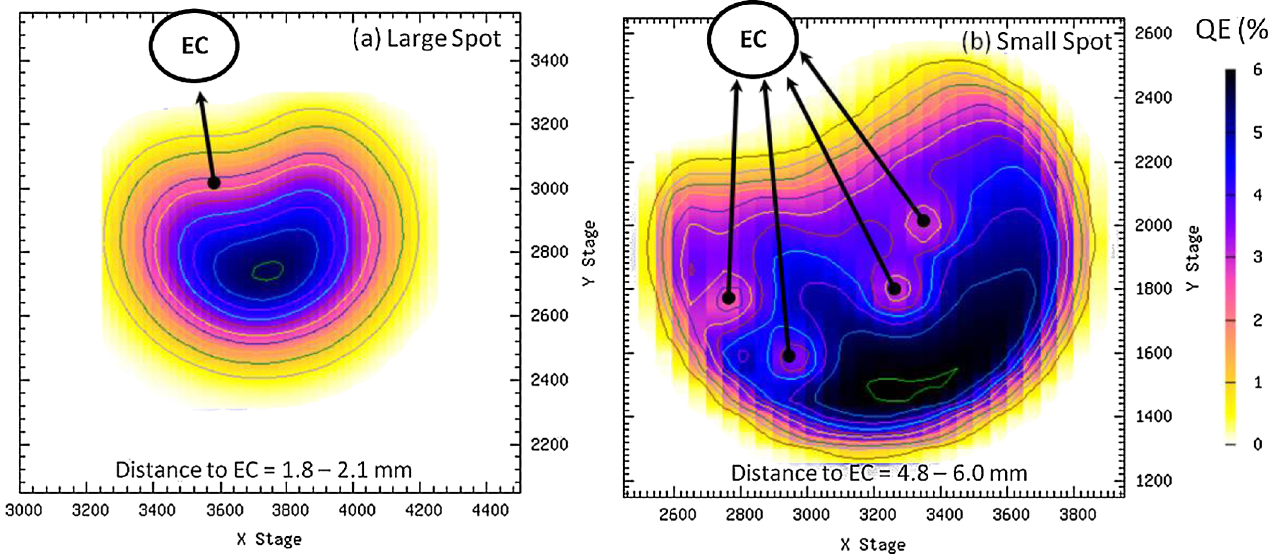
FIG. 10. False color plots of photocathode QE after the (a) large and (b) small laser spot size lifetime measurements. The arrows indicate the direction of lowest to highest energy ions, and relative distance, from the laser spot toward the estimated location of the